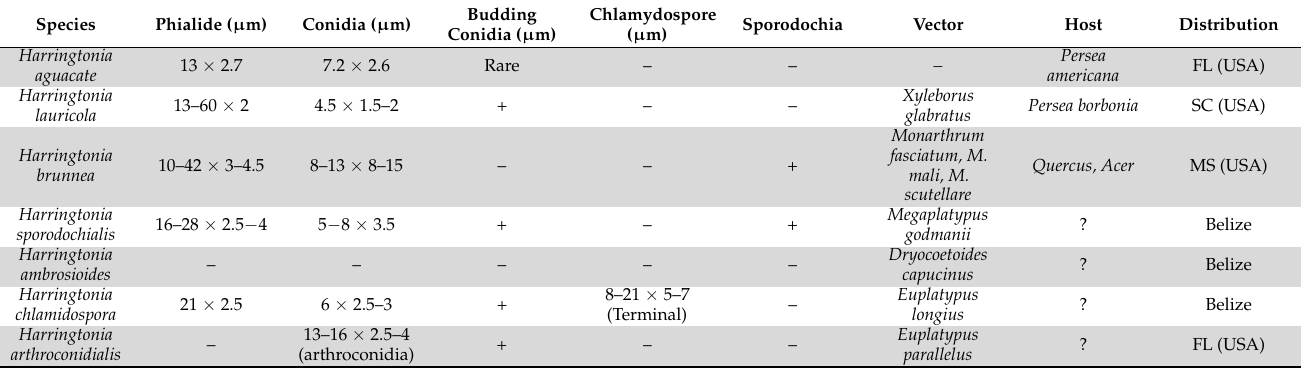
Table 1. Morphological features, Vector, Host and Distribution information of Harringtonia